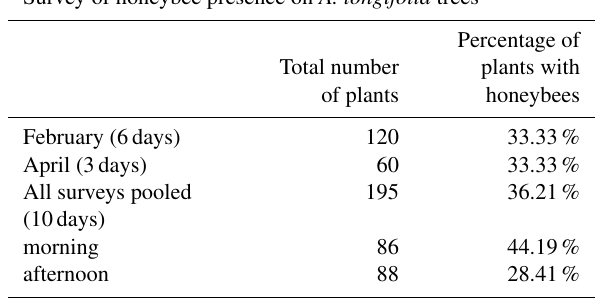
Table 1. Details of honeybee survey and behavioural observations. Survey of honeybee presence on A. longifolia